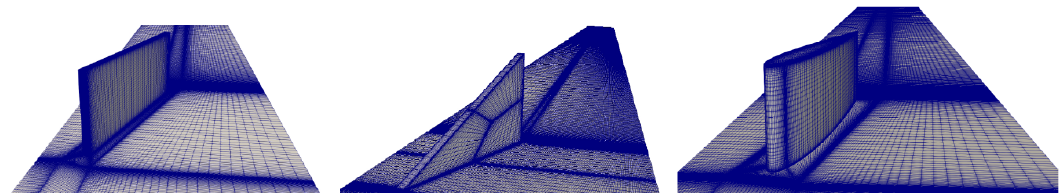
Figure 5. Structured meshes and refined edges for all studied cases. Rectangular VG, Triangular VG, Symmetrical VG NACA0012,